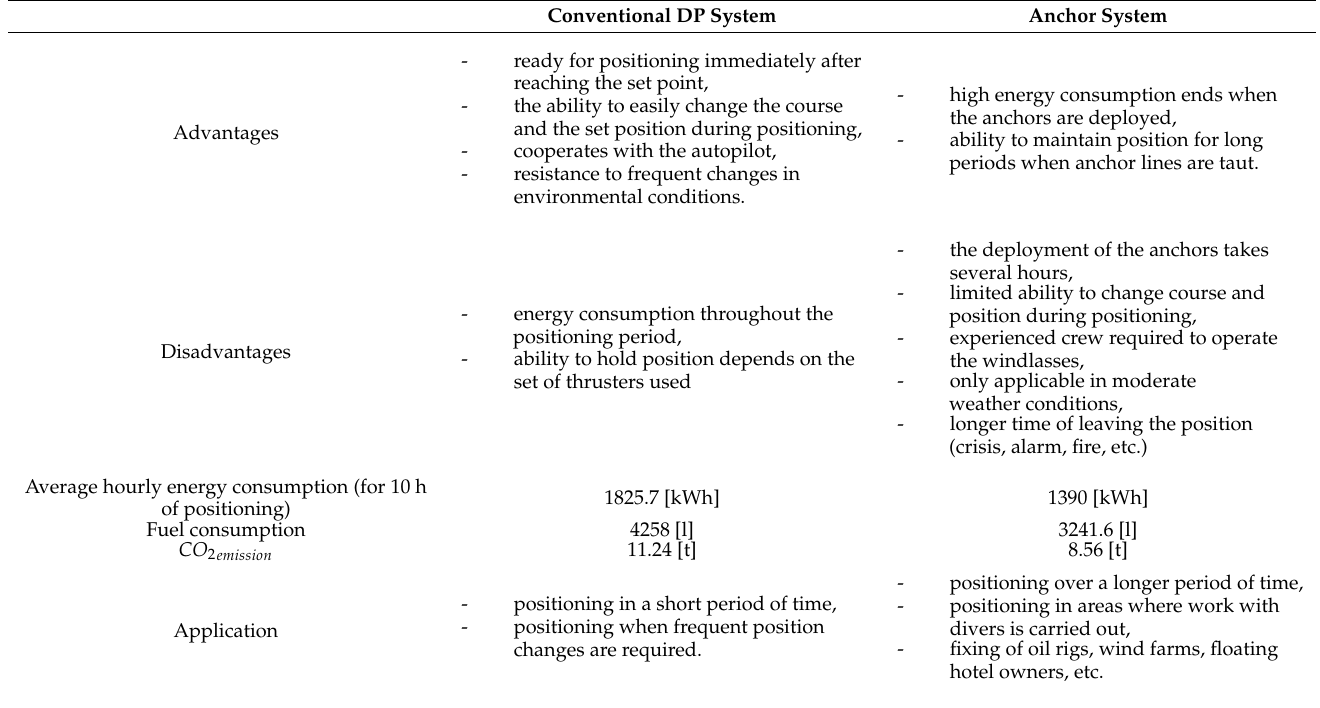
Table 9. Comparison of the dynamic positioning system and the positioning system with a set of anchors.